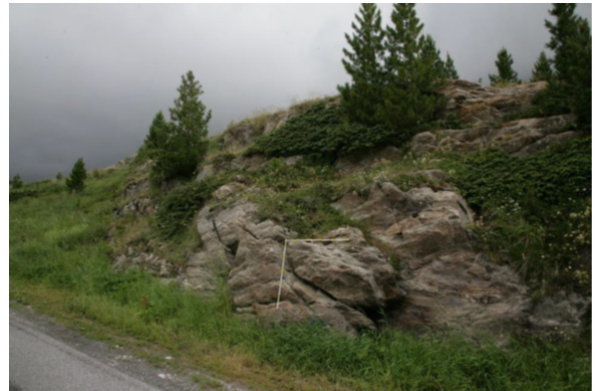
Figure 6. Test site for vegetation mapping by close-range